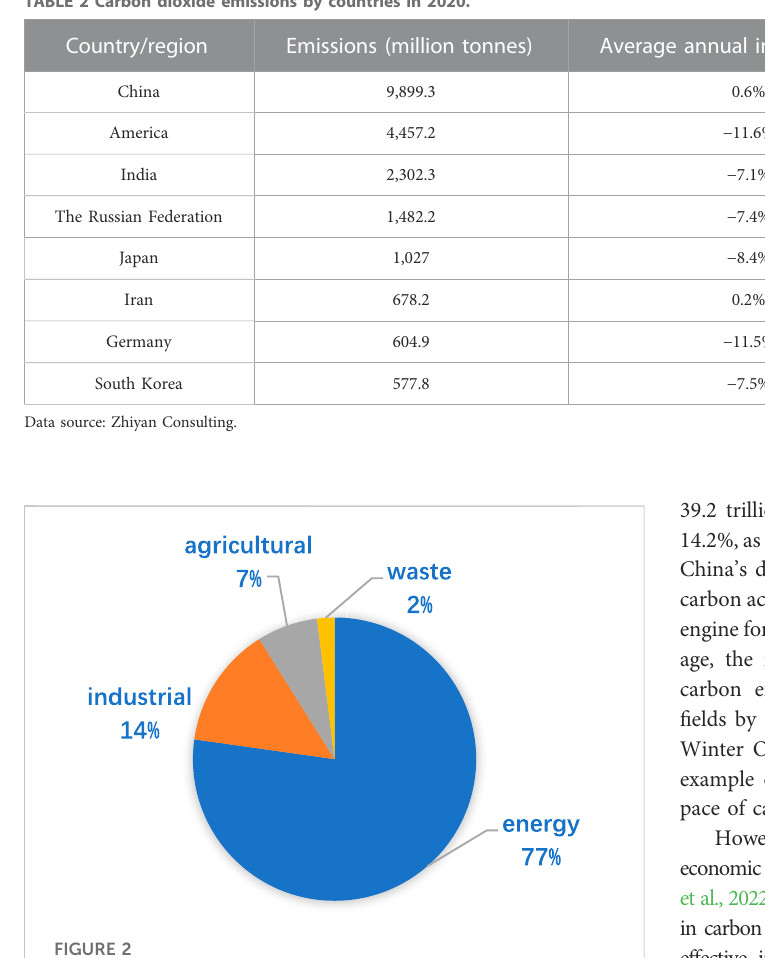
FIGURE 2 China ’ s 2020 carbon emissions (data source: China ’ s Academy of Information and Communications